Question: Express in one sentence what the figure is showing.
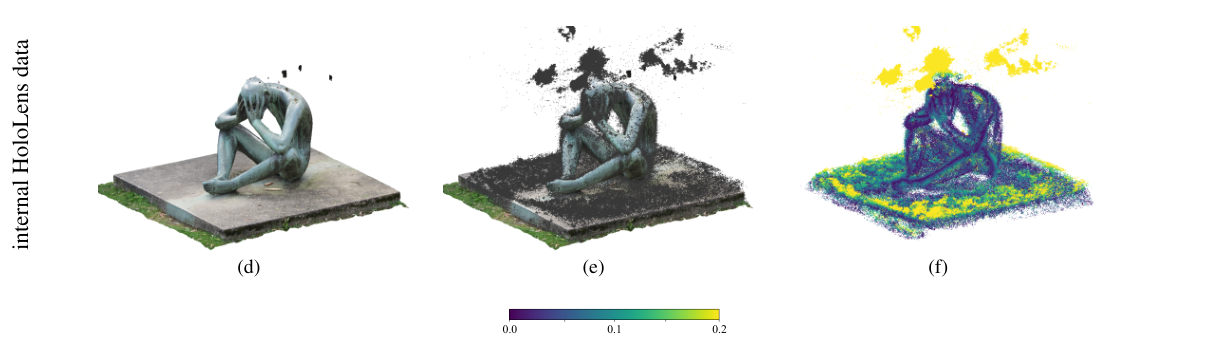
Answer: Geometric accuracy via Chamfer Distance ↓. Reference point cloud from MVS compared to the densified point clouds from Gaussian Splatting by extracting the center of each Gaussian. Top: Scene ’Denker’ with external SfM data. From left to right: (a) Reference, (b) reference and GS point cloud, (c) Chamfer Distance of the GS point cloud. Bottom: Scene ’Denker’ with internal HoloLens data. From left to right: (d) Reference, (e) reference and GS point cloud, (f) Chamfer Distance of the GS point cloud.